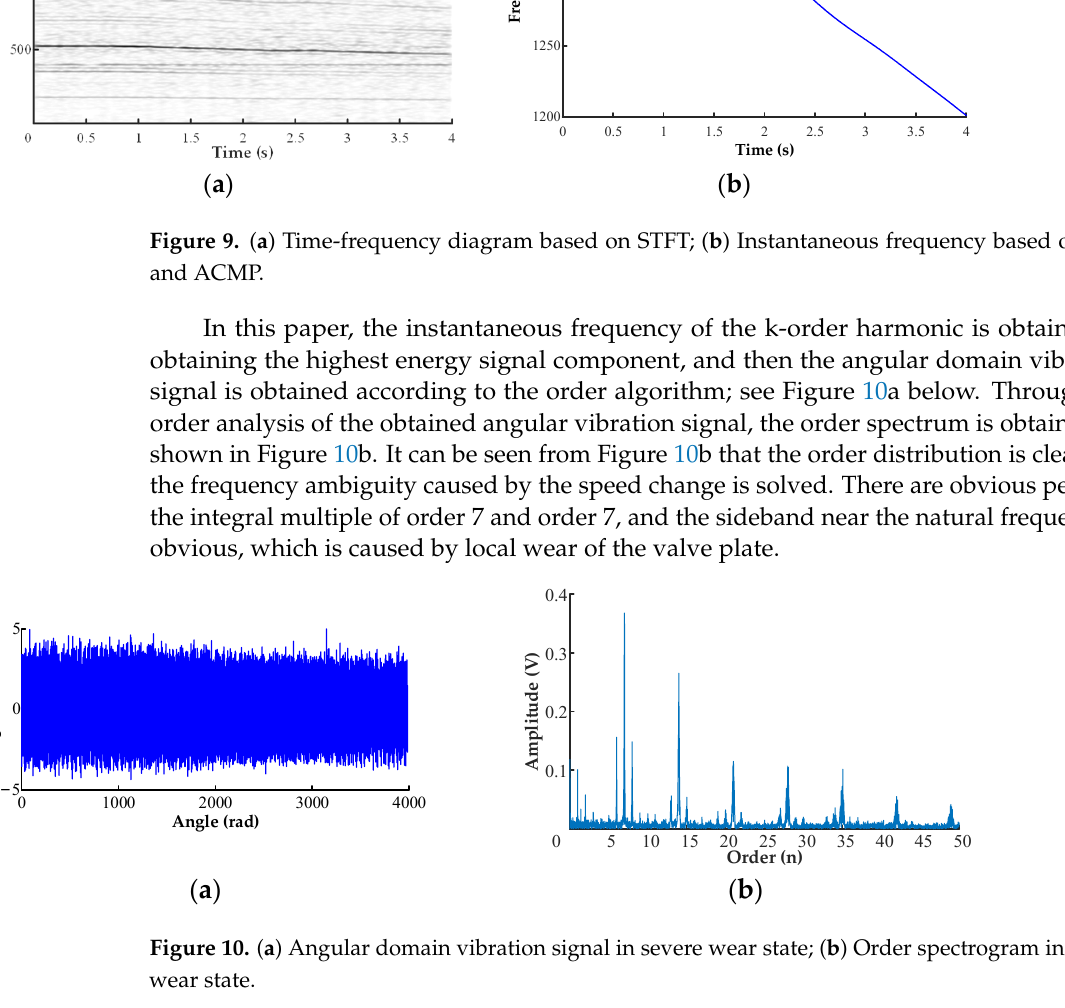
( f ) Figure 11. Angular domain vibration signal and order spectrogram under different wear states. ( a ) Angular vibration signal in zero wear state; ( b ) Angular vibration signal in mild wear state; ( c ) An- gular vibration signal in moderate wear state; ( d ) Order spectrogram in zero state; ( e ) Order spec- trogram in mild state; ( f ) Order spectrogram in moderate state. Observing the order spectrum of four different states, it can be seen that the ampli- tude of the order spectrum gradually increases with the continuous increase of wear, and the increase is more pronounced at order 7 and its integral multiples. In the entire order spectrums, the amplitude in the zero-wear state is significantly smaller than that in the worn states. As the wear of the piston pump valve plate increases, the energy of the order band in the corresponding order spectrum also shows a trend of increasing gradually, the